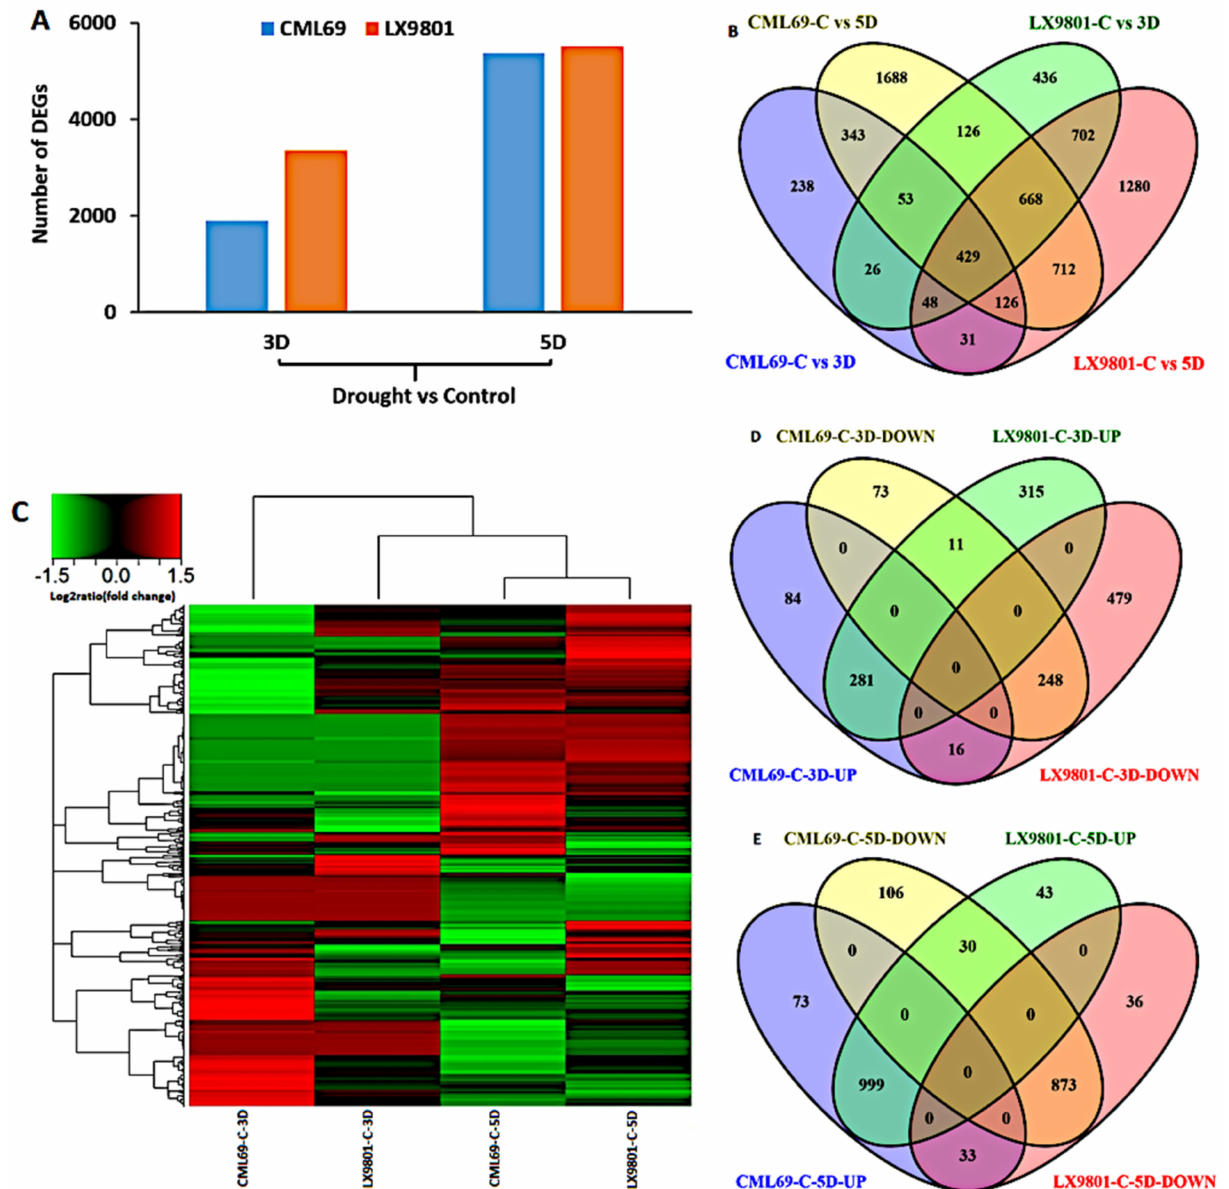
Figure 2. Differentially expressed genes (DEGs) in CML69 and LX9801 during drought conditions. ( A ) Graphic presentation of DEGs in 3D and 5D stress treatment of both CML69 and LX9801. ( B ) Venn diagram showing DEGs’ profile in both inbred lines after drought treatment. ( C ) Heatmap showing the clustering analysis of 2219 common drought-responsive genes. ( D ) Venn diagram showing the comparison of DEGs expressed at 3D drought stress in both inbred lines. ( E ) Venn diagram showing the comparison of DEGs expressed at 5D drought stress in both inbred lines. Drought treatments are labeled as control (C), three days (3D), and five days